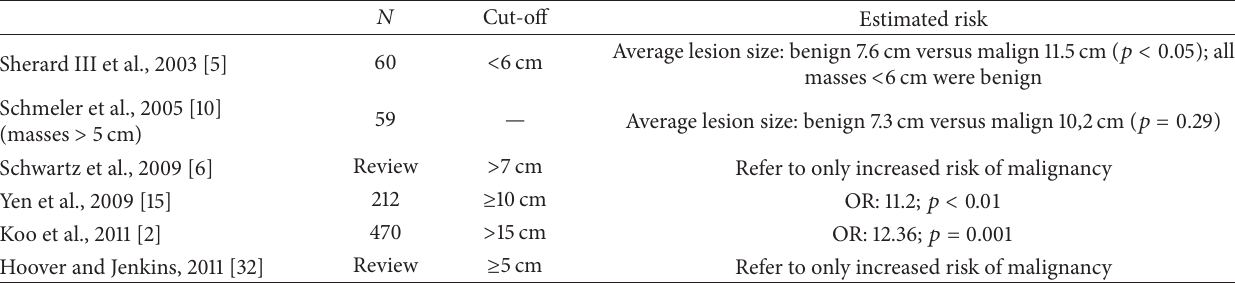
Table 6: Size of the adnexal mass and risk of malignancy.